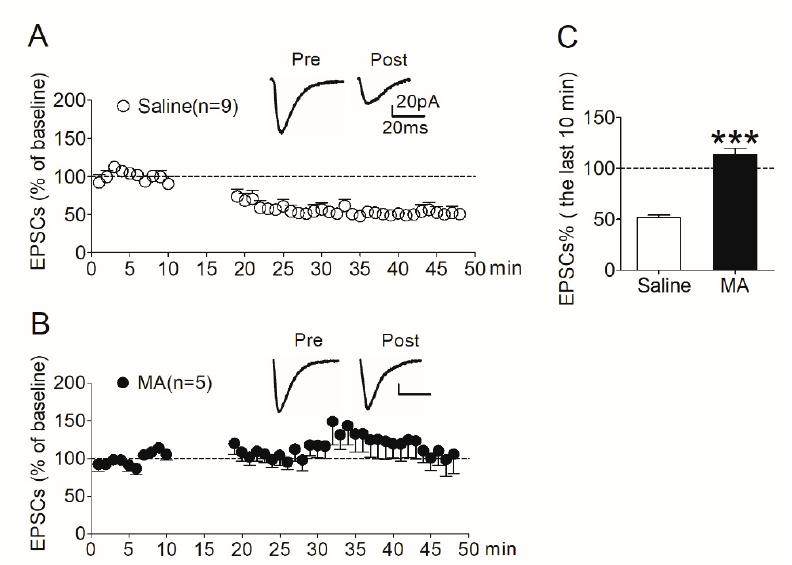
Figure 5. LTD induced in the NAc shell was absent in rats pretreated with MA. ( A ) LTD was induced robustly (51.8 ± 2.34% of baseline, n = 9) in saline controls. ( B ) LTD was absent (113 ± 6.31% of baseline, n = 5) in MA-pretreated rats. ( C ) Average EPSCs (% of baseline) recorded in the last 10 min after induction in the two groups. Asterisks indicate a significant difference (*** p < 0.001) between saline controls and MA group. Data are expressed as mean ± SEM.